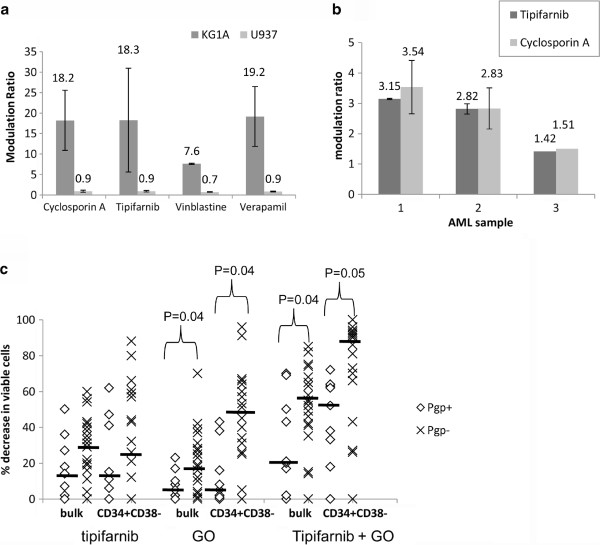
Pgp function is inhibited by tipifarnib. (a) Rhodamine 123 modulation ratio 75 minutes after treatment is shown in Pgp positive (KG-1a) and Pgp negative control (U937) cells treated with 2.5 μg/ml cyclosporin A, 5 μM vinblastine, 20 μM verapamil or 5 μM tipifarnib, mean +/− standard deviation of three separate assays (b) Rhodamine modulation by tipifarnib compared to cyclosporin in three different primary AML samples. (c) Percentage loss of viable cells is shown following 48 hour culture of nine Pgp positive and twenty three Pgp negative primary samples. Median values are shown by solid bars